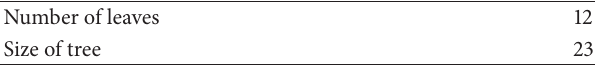
Table 2: Classification results of 200 user datasets.